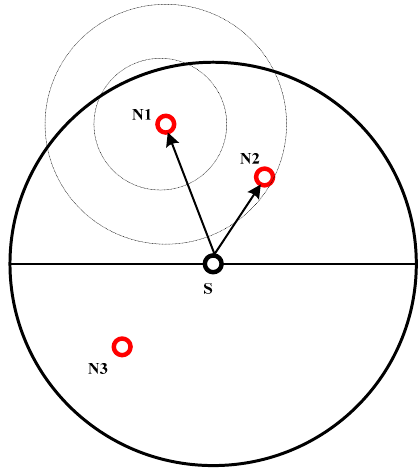
Figure 11. Route discovery phase in DBMR.